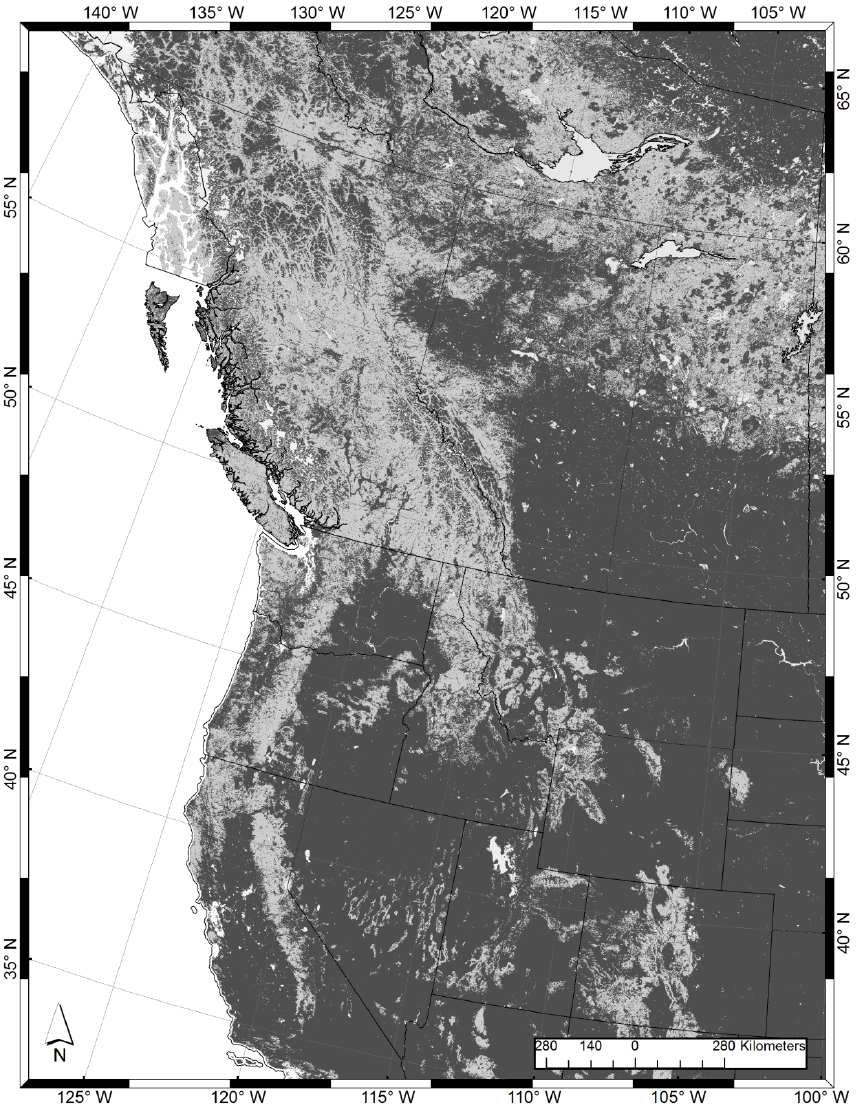
Figure 2. Pacific Northwest Study Area with barriers to migration recognized at three levels of increasing resistance to migration. Land cover classes are weighed to reflect the relative difficulty that they might represent to migration. The lowest impedance was assigned to natural vegetation (dark grey), then developed and mosaic types (black) to impenetrable landscape barrier, such as water (light grey).